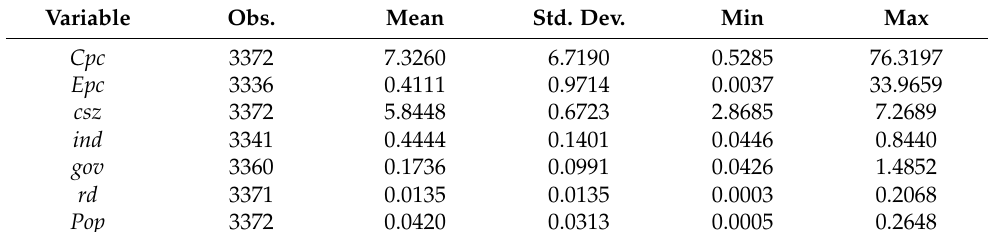
Table 3. Statistical analysis of the main variables.